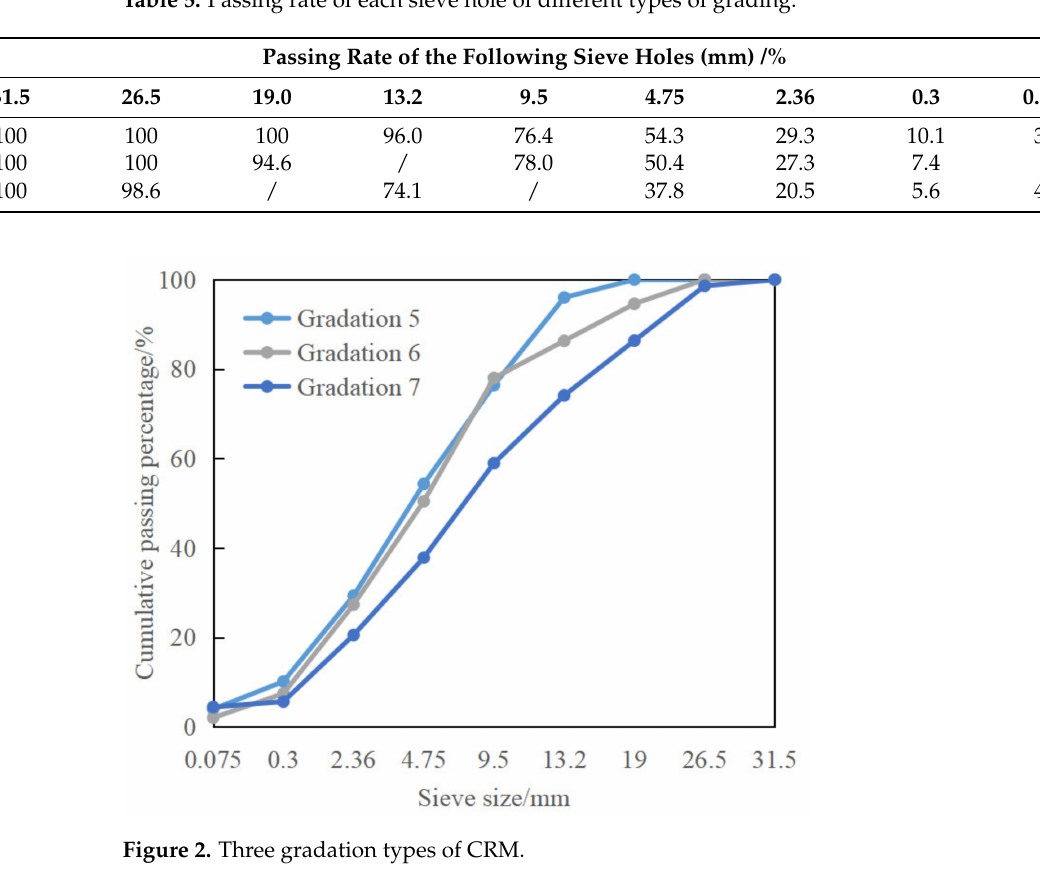
Table 5. Passing rate of each sieve hole of different types of grading.